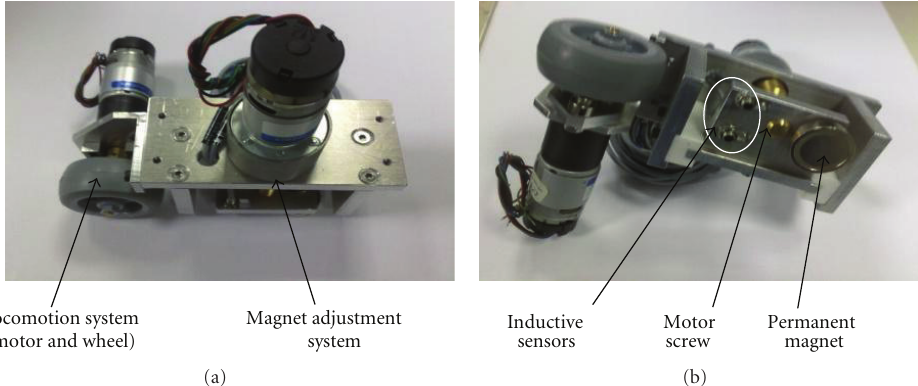
Figure 4: Locomotion system (motor and wheel) and magnet adjustment system (a) and the two inductive sensors, motor screw and magnet